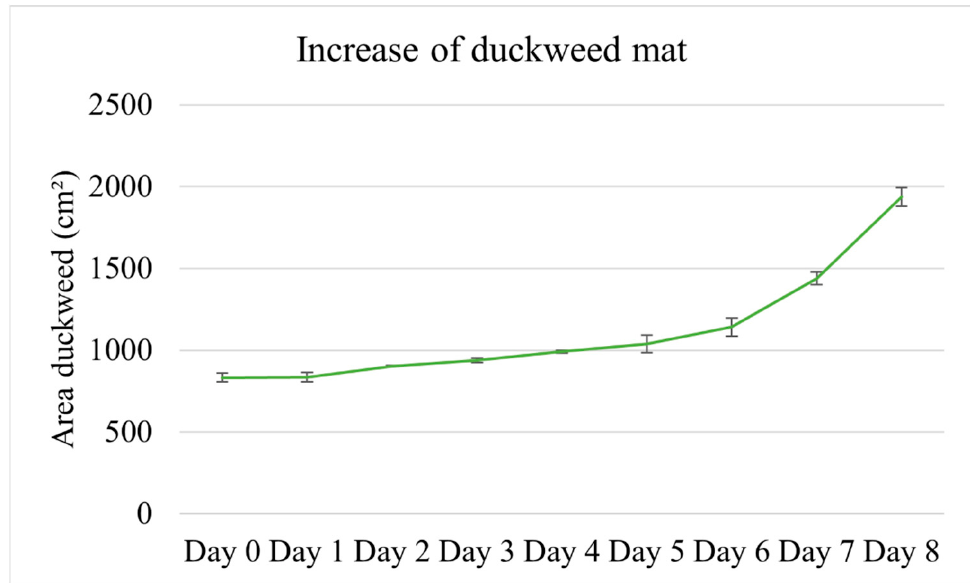
Figure 10. Increase in surface area covered by duckweed mat during the eight days of the experiment. Error bars are standard deviations.